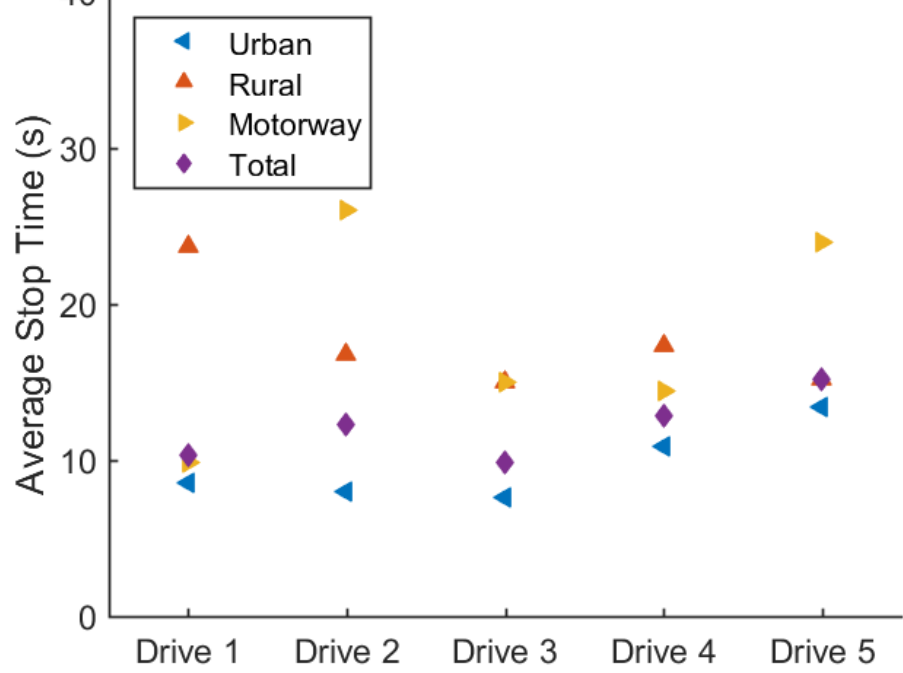
Figure 11. Average stop time for each section of the drive, by topographical